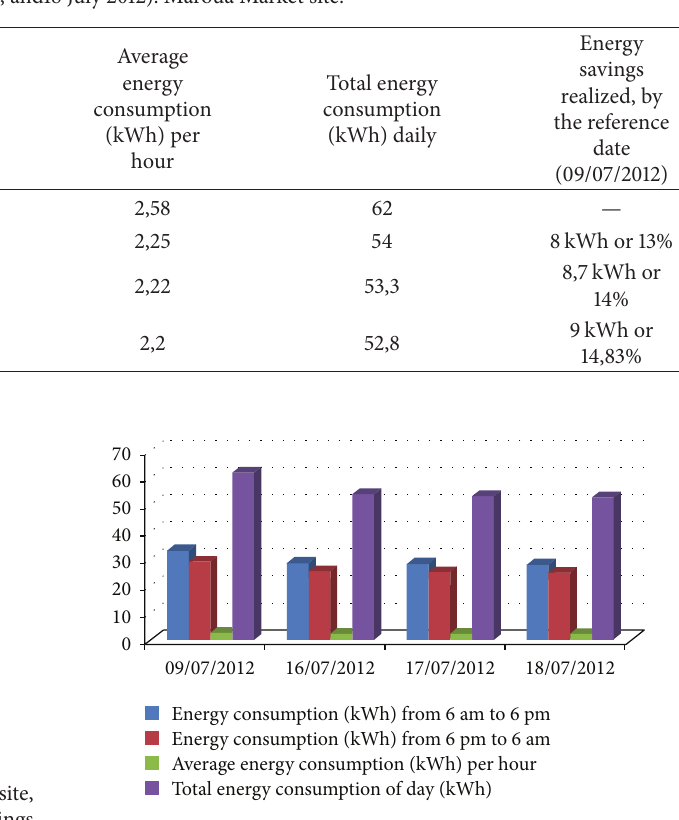
Figure 13: Comparison between the energy consumption of the site, case of a day not applying the proposals of energy savings (09/07/2012) and case of days applying the proposals of energy savings (16, 17, and 18 July 2012): Maroua Market site.